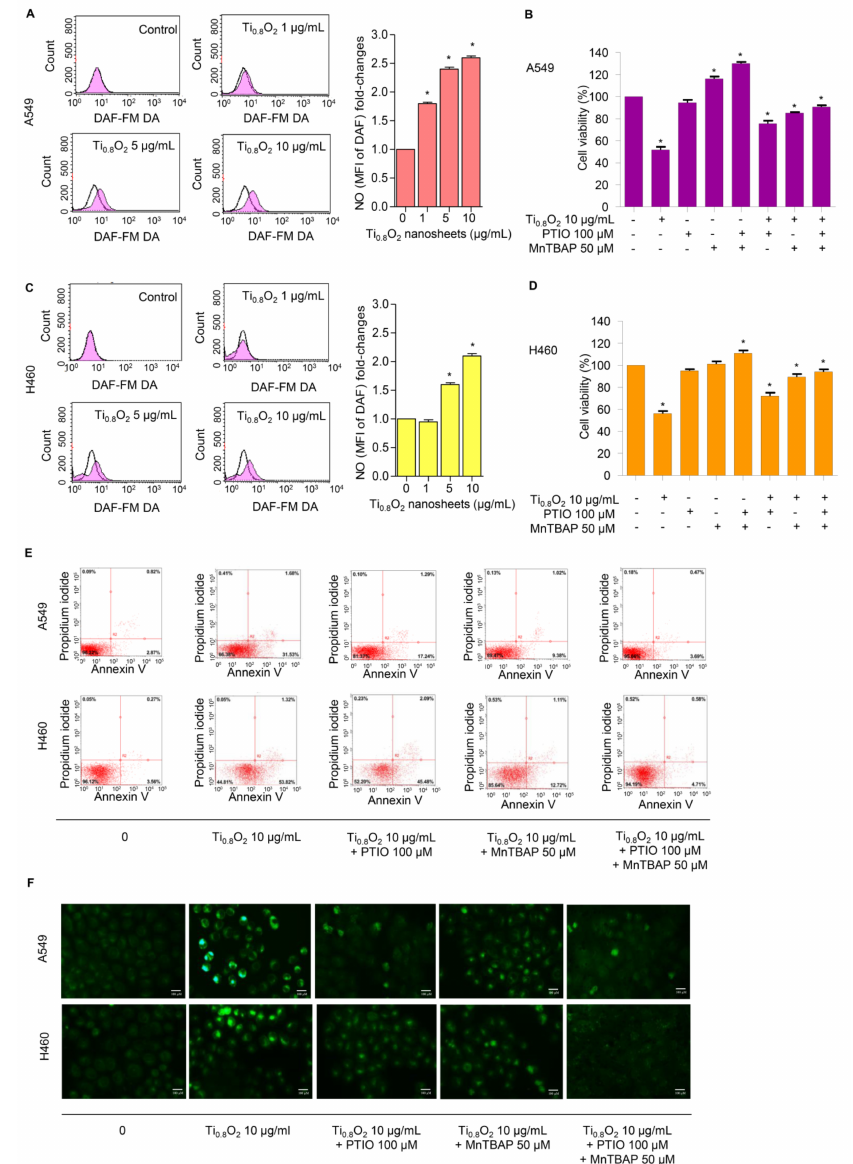
Figure 6. Ti 0.8 O 2 nanosheets induced NO in A549 and H460 cells and mediated peroxynitrite generation in these cells. ( A , C ) Effect of Ti 0.8 O 2 nanosheets on NO levels in A549 and H460 cells. Cells were treated with DAF-FM DA and various concentrations of Ti 0.8 O 2 nanosheets (0–10 µ g/mL) for 30 min, and the peroxynitrite levels were determined at 3 h by flow cytometry. NO levels are presented as mean fluorescence intensity (MFI); ( B , D ) the cytotoxic effect of Ti 0.8 O 2 nanosheets and the NO scavenger (PTIO) on A549 and H460 cells. Effect of Ti 0.8 O 2 nanosheets and the NO scavenger (PTIO) on cell viability. Cells were treated with Ti 0.8 O 2 nanosheets (10 µ g/mL) in the presence or absence of pretreatment with a NO scavenger (PTIO) (100 µ M) or pretreatment with a superoxide inhibitor (MnTBAP) (50 µ M) for 24 h by MTT assay; ( E ) apoptotic and necrotic cells were determined using annexin V-FITC/PI staining with flow cytometry; ( F ) cellular NO level stained with DAF-FM DA in cells treated with Ti 0.8 O 2 nanosheets (10 µ g/mL) or pretreated with PTIO (100 µ M) or MnTBAP (50 µ M) were determined by visualization under a fluorescence microscope. All data are shown as the mean ± SEM ( n = 3). * p < 0.05 compared with the untreated